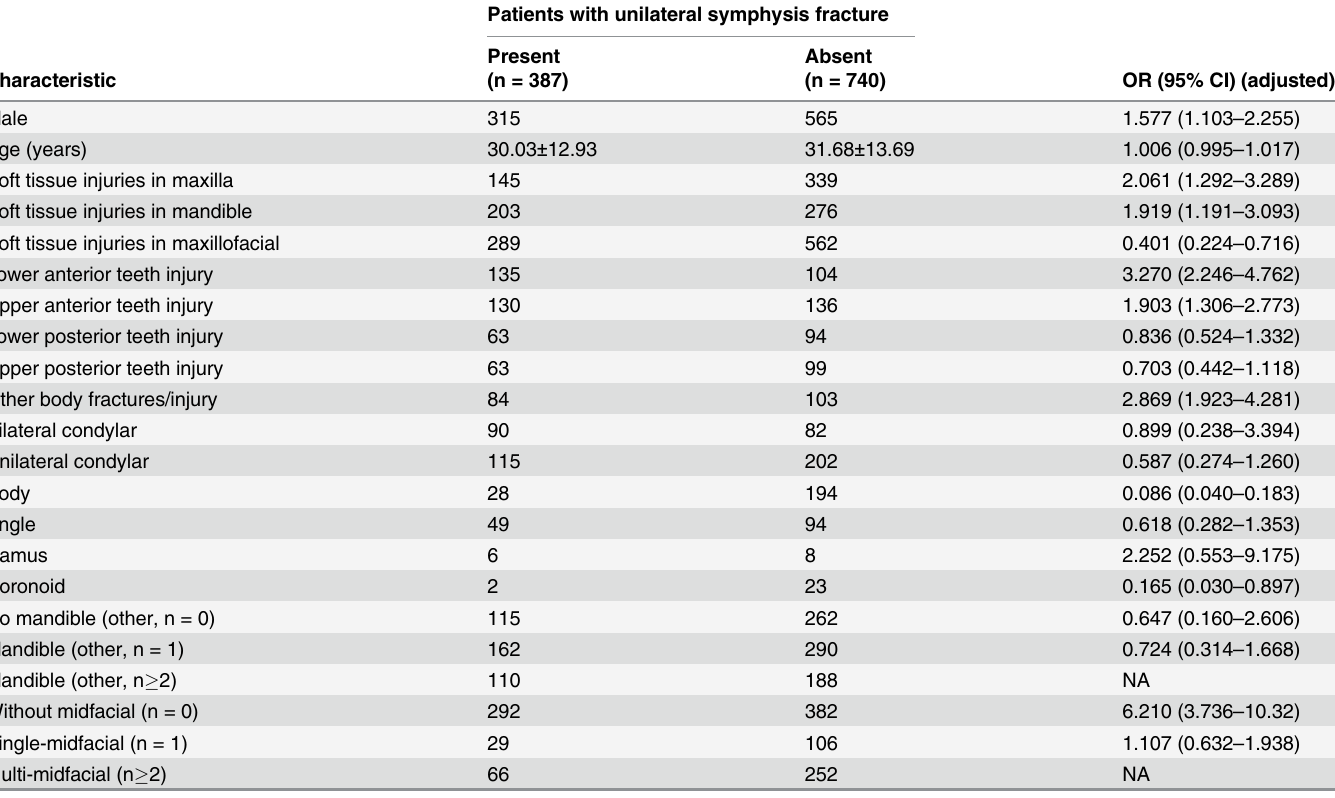
Table 1. Multivariate logistic regression analysis of patients with unilateral symphysis fractures. Patients with unilateral symphysis